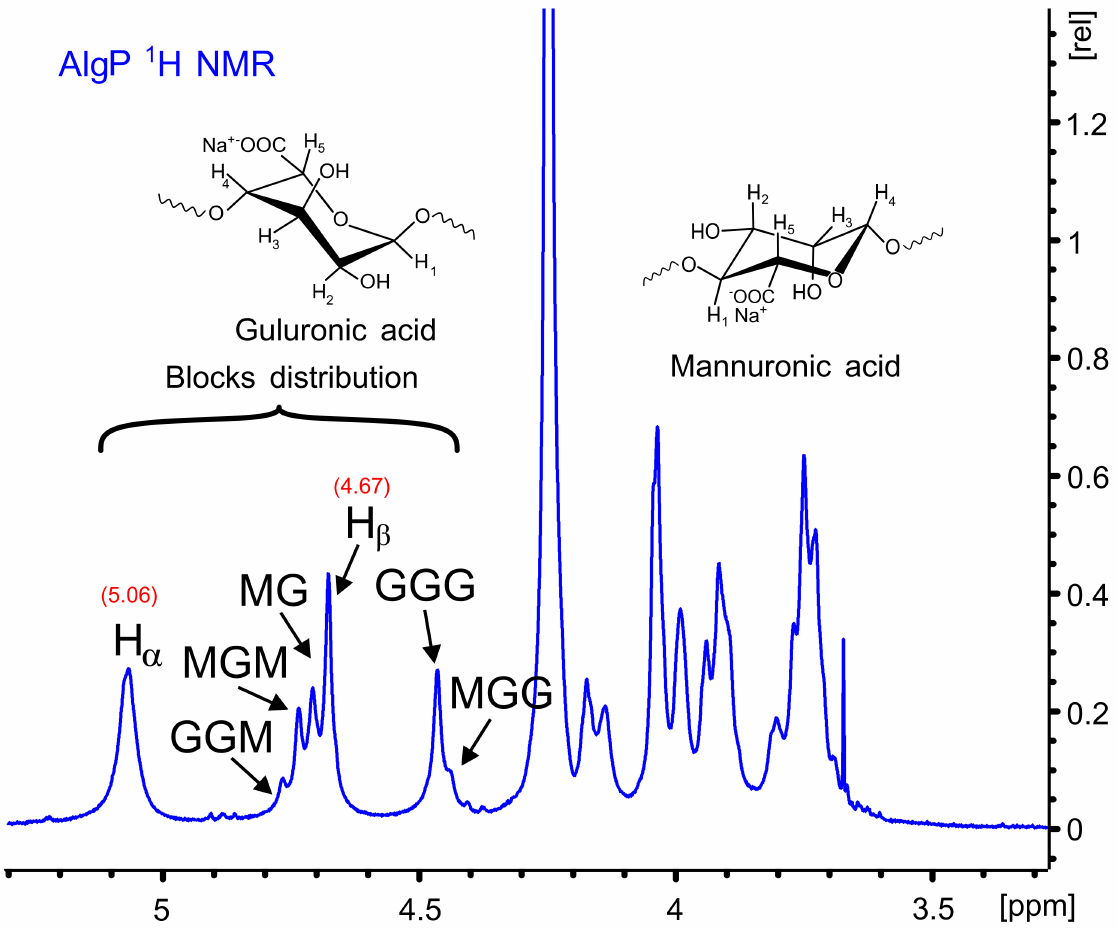
Figure 4. 1 H NMR spectrum of